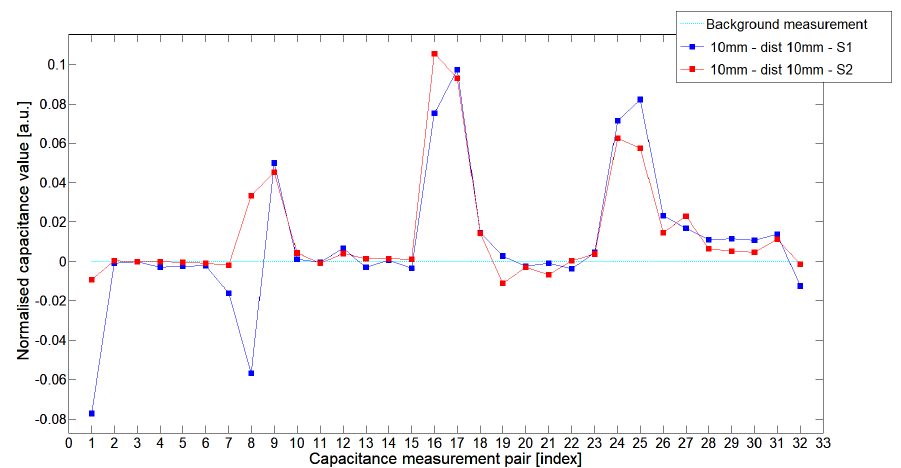
Figure 23. The 1st electrode measurement cycle (S1: 1->32 and S2: 1->32) for Test10 P 3 and S1—blue line, S2—red line. Cyan line indicates lower calibration